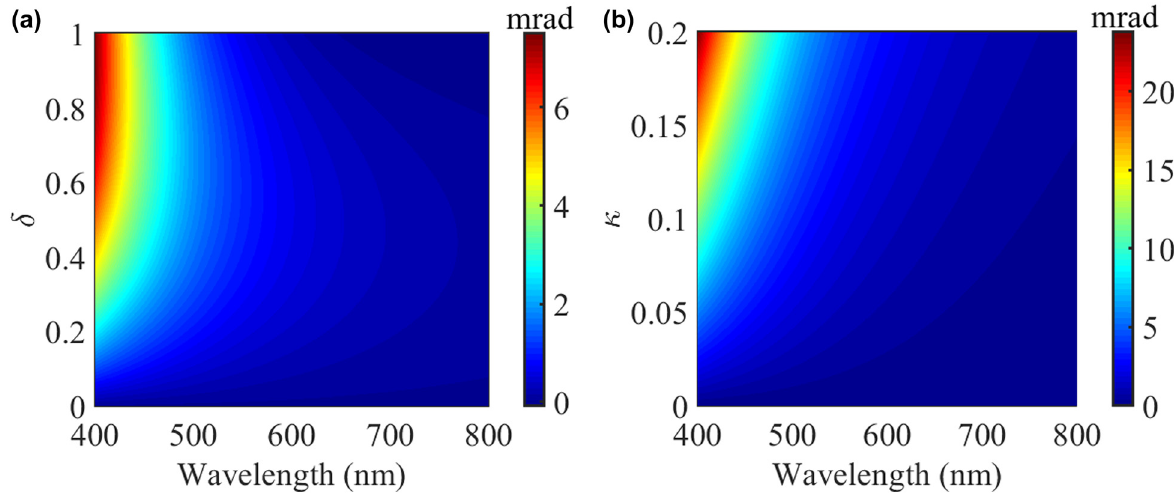
Figure 5: (a) Ellipticity of scattered fields in the forward direction as a function of non-Hermiticity parameter and wavelength. The chirality parameter is κ = 0.05. (b) Ellipticity of scattered fi eld in the forward direction as a function of chirality parameter and wavelength. The non- Hermiticity parameter is δ = 0.5. The incident plane wave is linearly polarized plane wave without